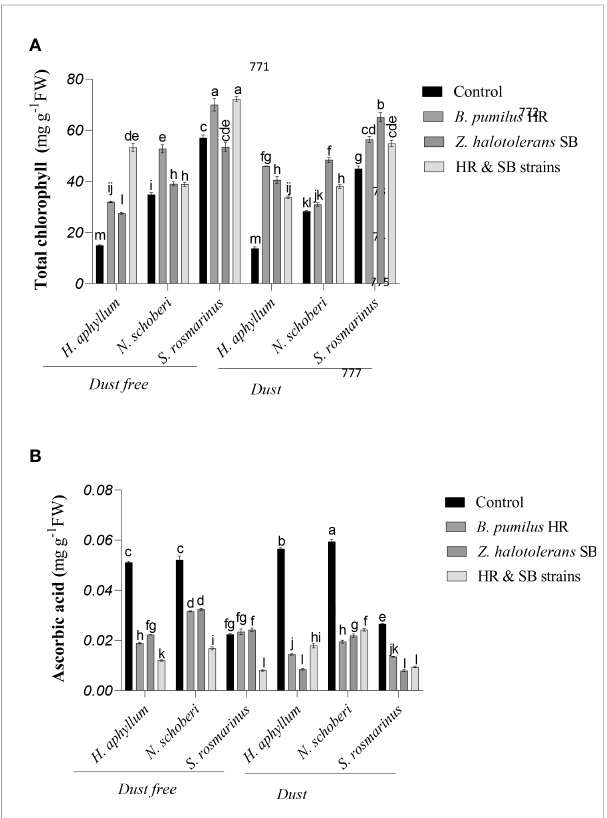
FIGURE 1 Triple interactions of treatments of bacterial strains, three desert plant species of S. rosmarinus , H. aphyllum and N. schoberi and dust on the content of total chlorophyll (A) and ascorbic acid (B) of the leaves of three plant species grown under greenhouse conditions for fi ve months. Alphabets indicate signi fi cant differences among various treatments (Means ± SE, n = 3) according to Tukey ’ s multiple-range test at p